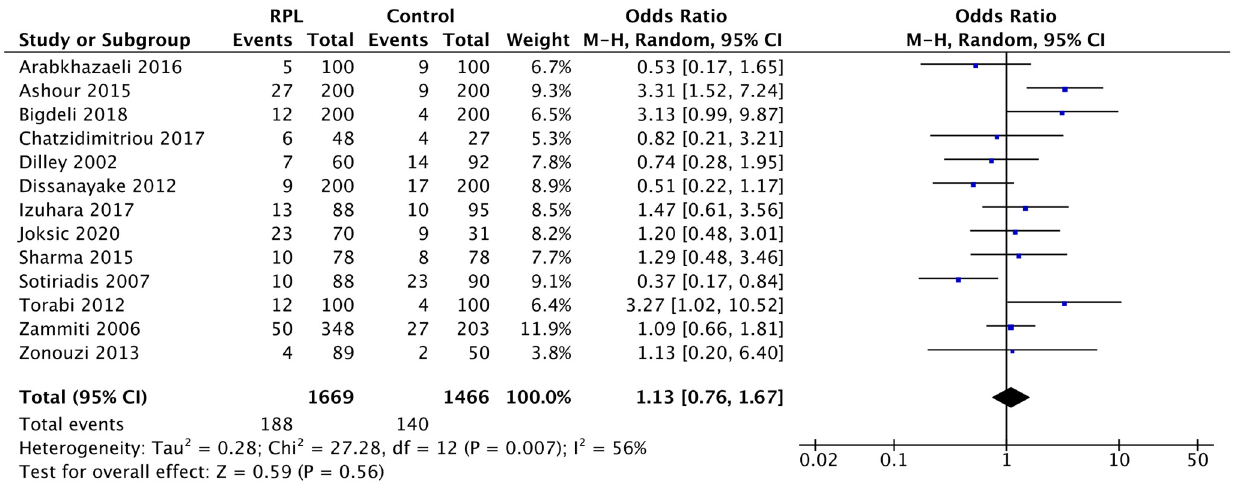
Figure 4. Forest plot of the association between H1299R heterozygous and RPL. The statistical value of every single study is expressed as OR. The horizontal black lines represent the confidence interval (95% CI). The blue squares indicate the weight of each study. The black diamond indicates the overall result of the statistical analysis. Heterogeneity is expressed as I 2 . Overall effect OR: 1.13 [0.76, 1.67]; p = 0.56.